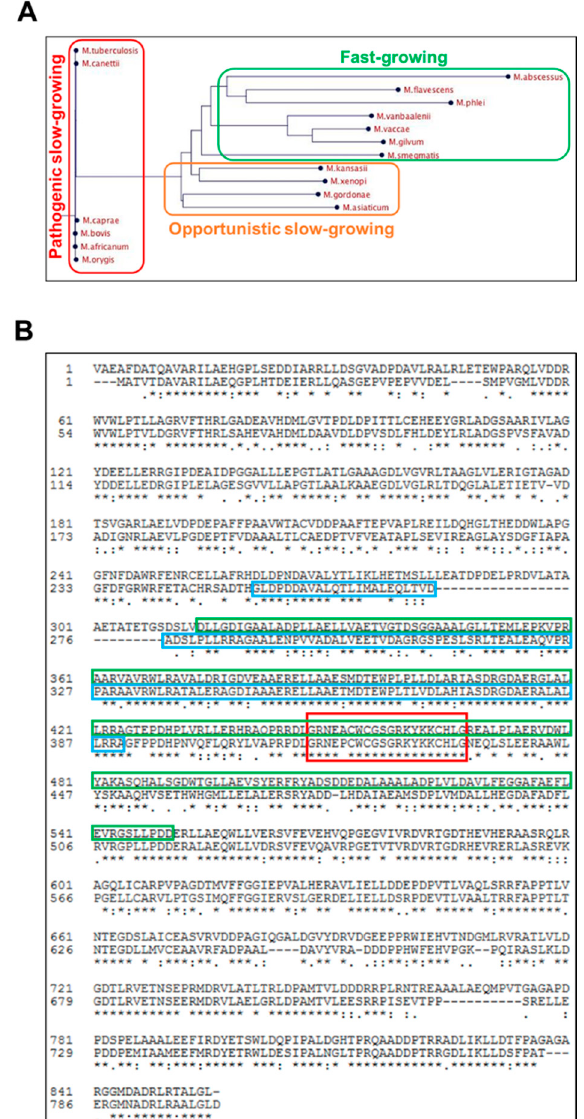
Figure 2. MSMEG_1285 is an orthologue of Rv0613c. ( A ) Phylogenetic tree representing Rv0613c homologues among different mycobacteria; ( B ) Sequence alignment of Rv0613c (first line) and MSMEG_1285 (second line) using Clustal Omega. The red rectangle corresponds to the SEC-C motif. The region interacting with HBHA of Rv0613c 314–550 is shown in the green rectangles, and the TPR of MSMEG_1285 is shown in the blue rectangles.